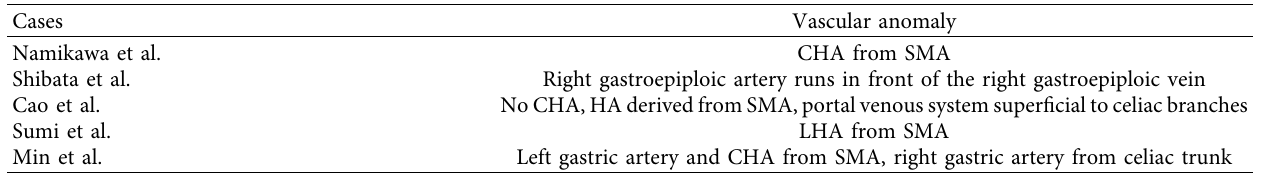
Table 6: Vascular anomalies found in SIT patients